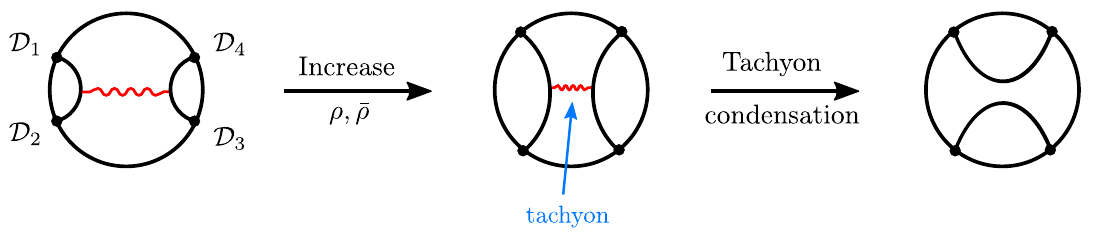
Figure 36 . The phase transition of the geodesic Witten diagrams and the tachyon condensation. If we increase the cross ratio (cid:26) (cid:22) (cid:26) , the original con(cid:12)guration of the geodesic Witten diagrams become unstable after some point owing to the open string tachyon. As a result of the tachyon condensation, the D-branes get recombined into di(cid:11)erent